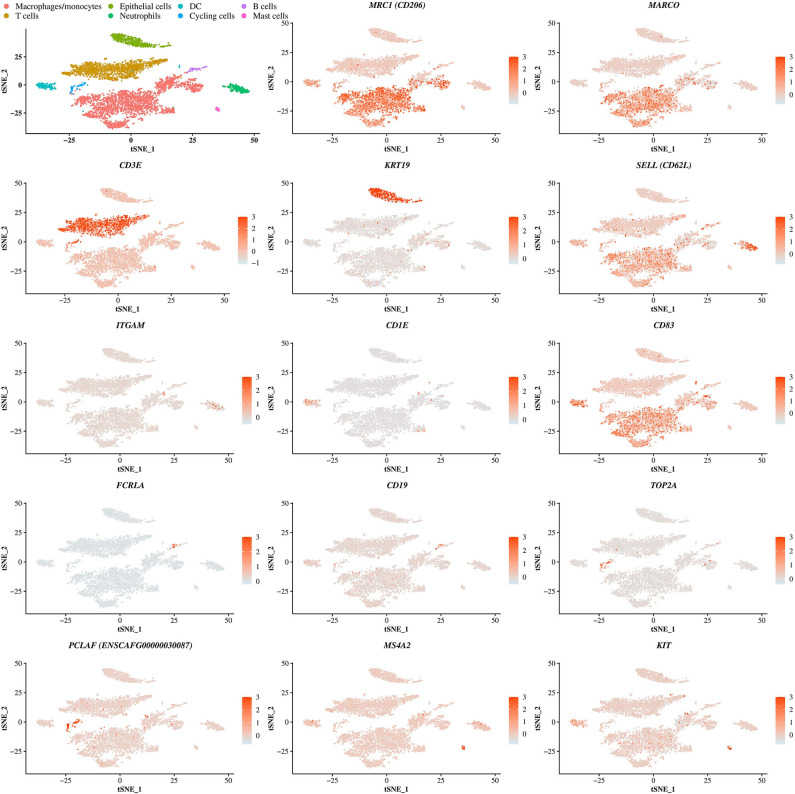
Identification of cell identity corresponding to the clusters. t-SNE plot showing the cells identity based on the expression of differentially expressed genes representative of each cells type including genes coding for the macrophage receptor with collagenous structure (MARCO), the macrophage mannose receptor (MRC1, encoding CD206), the T-cell surface glycoprotein CD3 epsilon chain (CD3E), the cytokeratin 19 (KRT19), the selectin (SELL, encoding CD62L), the integrin alpha M (ITGAM), the T-cell surface glycoprotein CD1e (CD1E), the CD83 molecule, the Fc receptor like A (FCRLA), the CD19 molecule, the DNA topoisomerase II alpha (TOP2A), the proliferating cell nuclear antigen clamp associated factor (ENSCAFG00000030087, encoding PCLAF), the membrane spanning 4-domains A2 (MS4A2) and the mast/stem cell growth factor receptor (KIT). DC, dendritic cell.